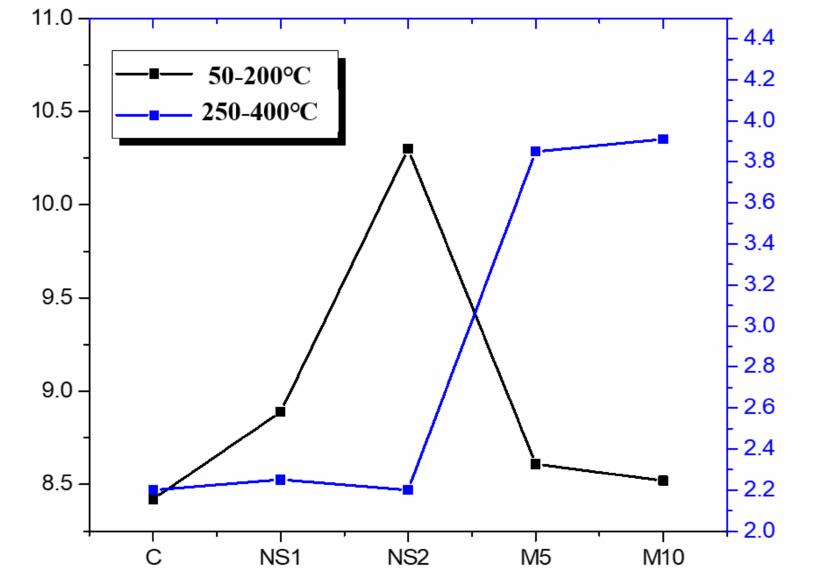
Figure 9. Mass loss fractions at different temperature ranges of the UWC mixes as a function of NS and